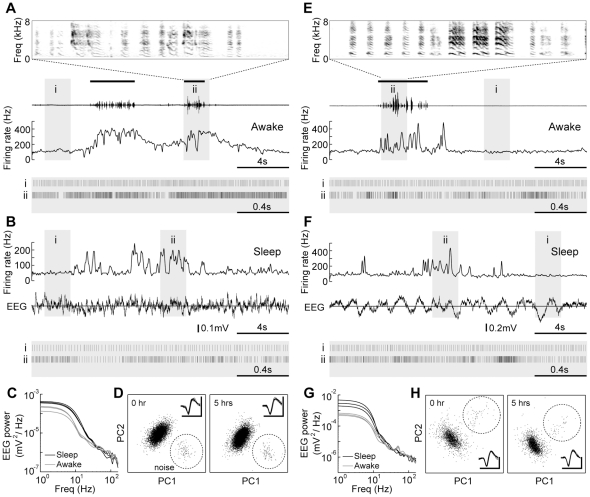
Area X pallidal neurons active during singing were also phasically active during sleep.
A–D, An example of pallidal unit recorded from a juvenile bird (bird #1, 61 days post-hatch). A, Activity during singing. Song (oscillogram, period of singing indicated by black bars) and smoothed firing rate (15 ms gaussian window) are shown. Spectrogram of song (2 second epoch, indicated by gray shade labeled ‘ii’) is shown at the top. Typical spiking activity during non-singing and singing periods (2 second epochs, indicated by gray shades labeled ‘i’ and ‘ii'’, respectively) are shown in raster plots below. B, Activity of the same unit during sleep. Simultaneously recorded EEG signal is shown below. Typical spiking activity during tonic and phasic epochs (2 second, indicated by gray shades) are shown by raster plots. C, Power spectral densities of 2 second period of EEG during awake (gray, 3 representative traces) and sleep (black, 3 representative traces) periods. Note stronger power of low-frequency band (<10 Hz) during sleep periods. D, Unit cluster at initiation of recording and 5 hours later. Black dots are a sorted single-unit. Noise cluster is encompassed with a dotted circle. Insets indicate spike waveforms. Scale bars; 0.3 mV, 1 ms. E–H, Another example of pallidal unit (bird #2, 59 days post-hatch). Data are shown as in A–D. Despite sleep EEG waveforms appear different in B and F, power spectral densities for both periods exhibited strong power at low-frequency band, suggesting that those sleep periods can be regarded as slow wave sleep. Audio files (Audio S1, S2) are available as Supporting Information.